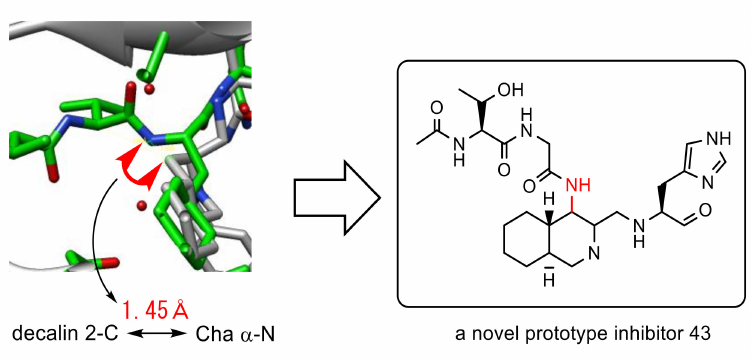
Figure 16. Design of a novel prototype nonpeptide